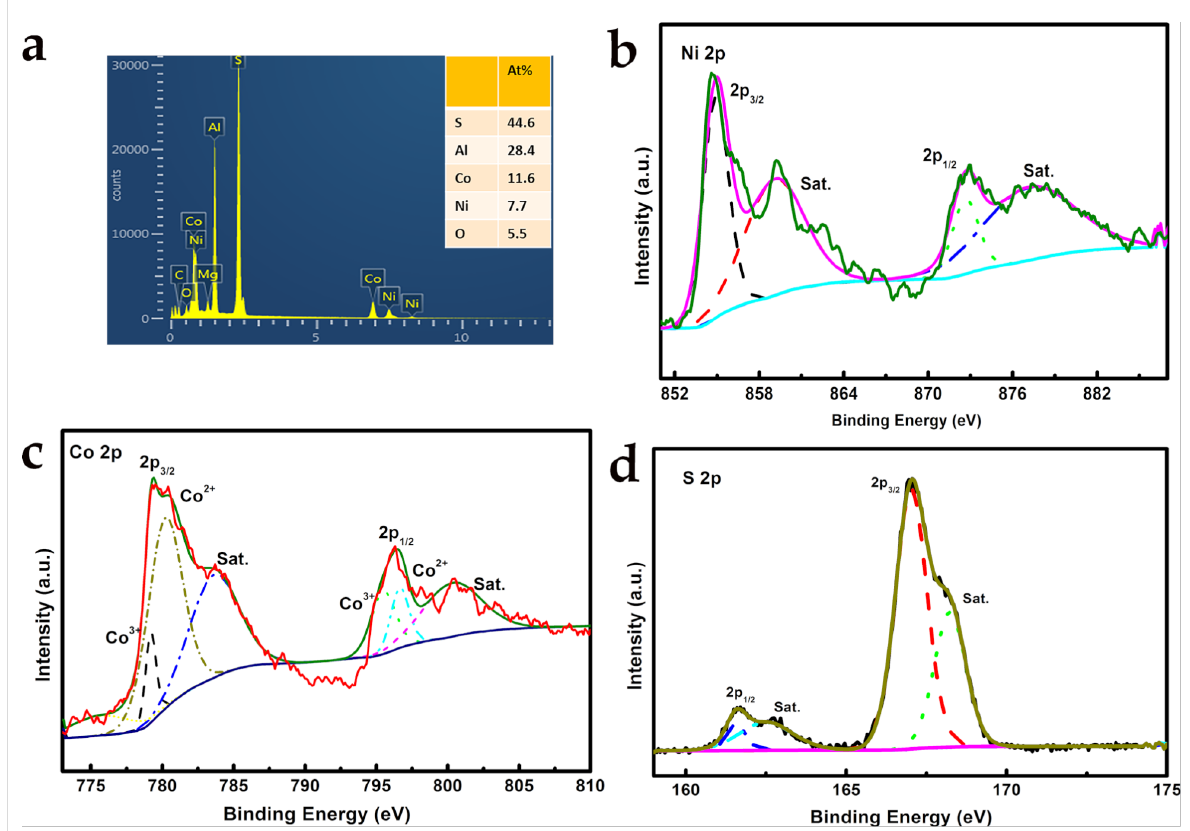
Figure 2: (a) EDS pattern of Ni 1 − x Co x S 2 and high-resolution XPS spectra of (b) Ni 2p, (c) Co 2p, and (d) S 2p for Ni 1 − x Co x S 2 .